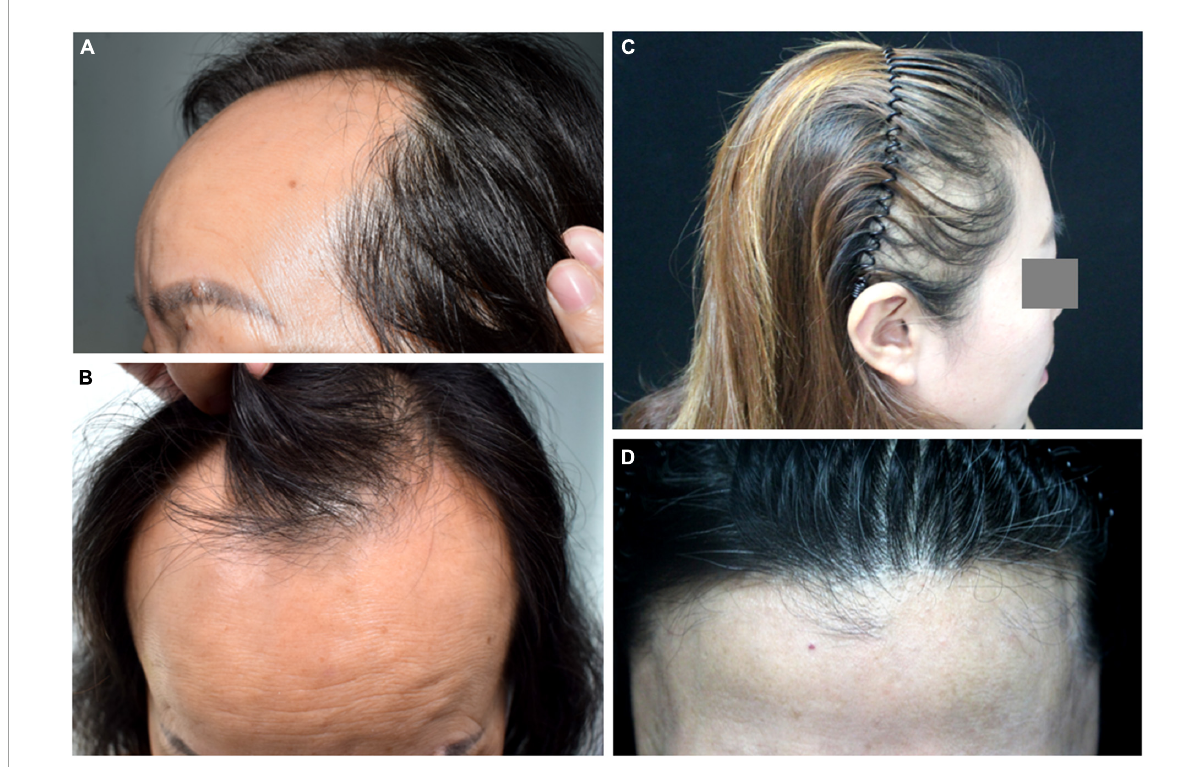
FIGURE1 Clinical manifestation of frontal fibrosing alopecia (FFA). (A,B) Pattern I of FFA. (C) Pattern II of FFA. (D) Pattern III of FFA, the pseudofringe sign.